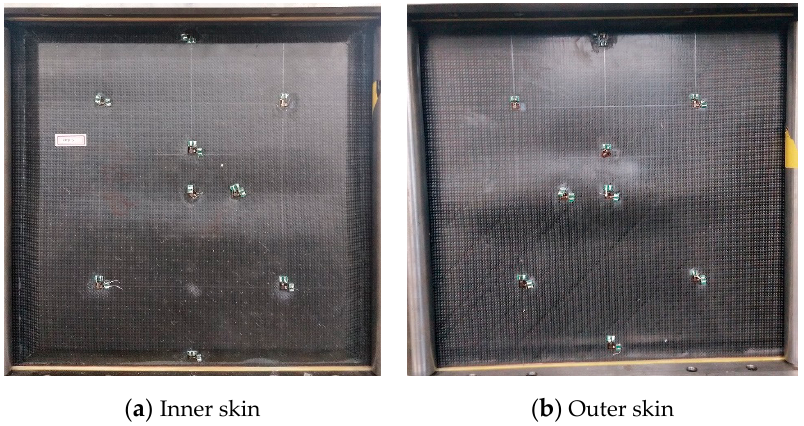
Figure 12. Compressive failure mode of CD80-3. ( a ) Failure mode of inner skin; ( b ) Failure mode of outer skin.